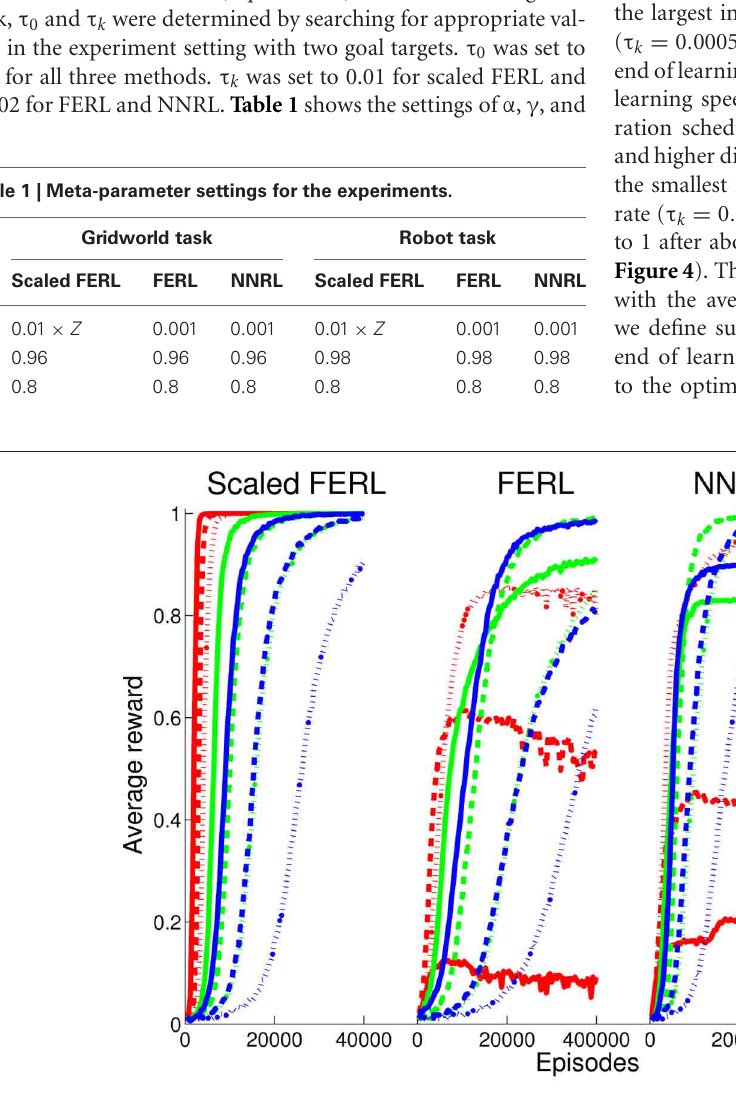
settings of τ k (red: 0.01, green: 0.001, and blue: 0.0005) and the line types correspond to the setting of τ 0 (solid: 0.5, dashed: 1, and dotted: